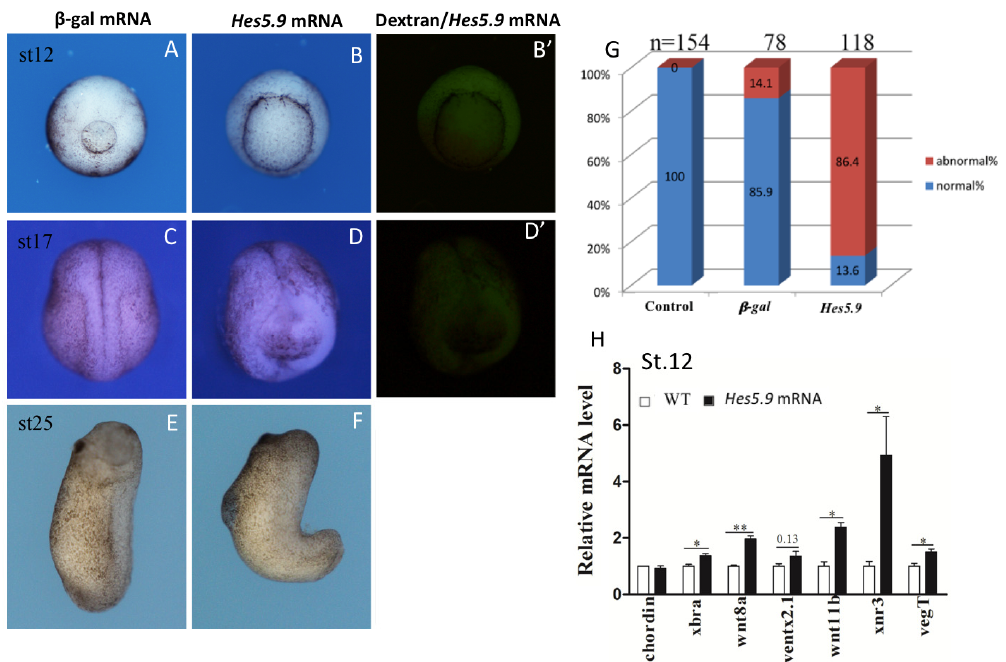
Figure 7. Overexpression of Hes5.9 resulted in defective embryo morphogenesis. Embryos were bilaterally injected dorsally with 250 pg Hes5.9 mRNA at the 4-cell stage, β -gal mRNA injected as a negative control, and dextran co-injected to indicate the inject site. ( A – F ) Ectopic expression of Hes5.9 mRNA perturbed embryos normal development during gastrulation and neurulation, open blastopore and abnormal neural fold was observed. ( G ) Statistical analysis of abnormality. ( H ) The expression levels of the representative marker genes were determined by RT-qPCR at stage 12, * p < 0.05; ** p < 0.01.